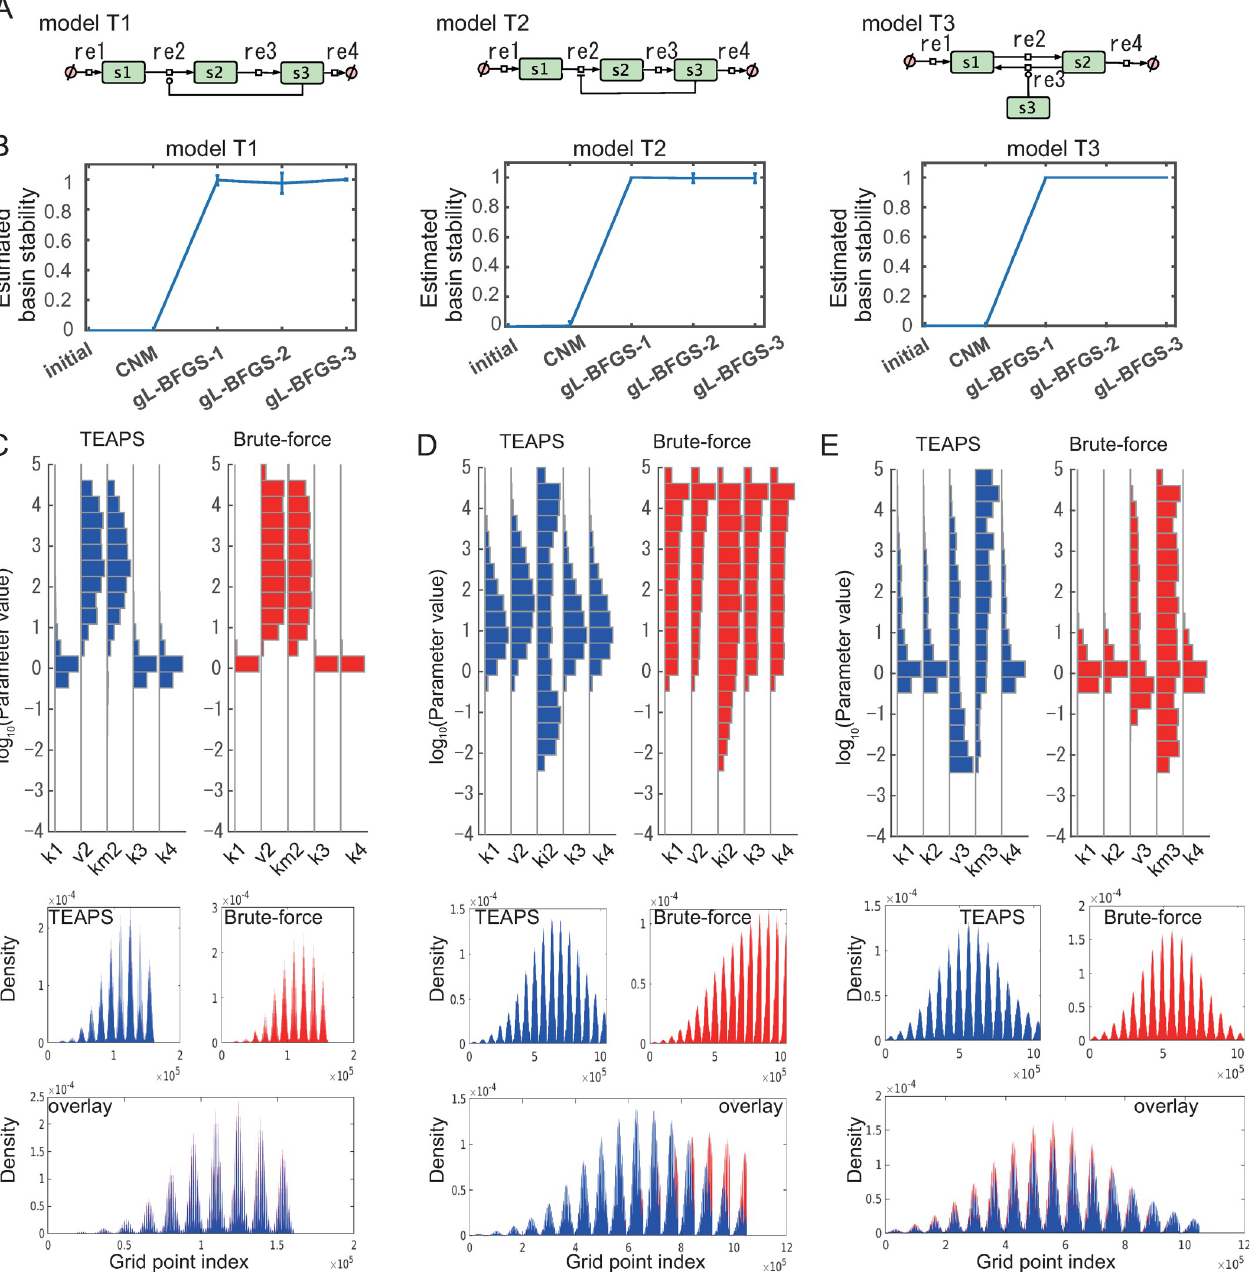
Fig 3. TEAPS search expands the basin stability during its process and found the parameter sets satisfying the BSR condition. (A) Three basic models were used for implementation of the BSR. (B) The estimated basin stability was increased by individual optimization process (gL-BFGS) of searching parameter sets satisfying the BSR condition using the TEAPS search algorithm. (C–E) Comparison of the parameter distributions found by the TEAPS and the brute-force searches as histograms or multidimensional density profiles for the models T1 (C), T2 (D) and T3 (E). The parameter sets satisfying the BSR condition were searched by TEAPS (upper left) or by the brute-force search (upper right), and the histograms of the distribution of the found parameter sets were compared. Density profiles of the obtained parameter sets were compared following the kernel density estimation (middle left: TEAPS, middle right: brute-force search). Two density profiles were overlaid